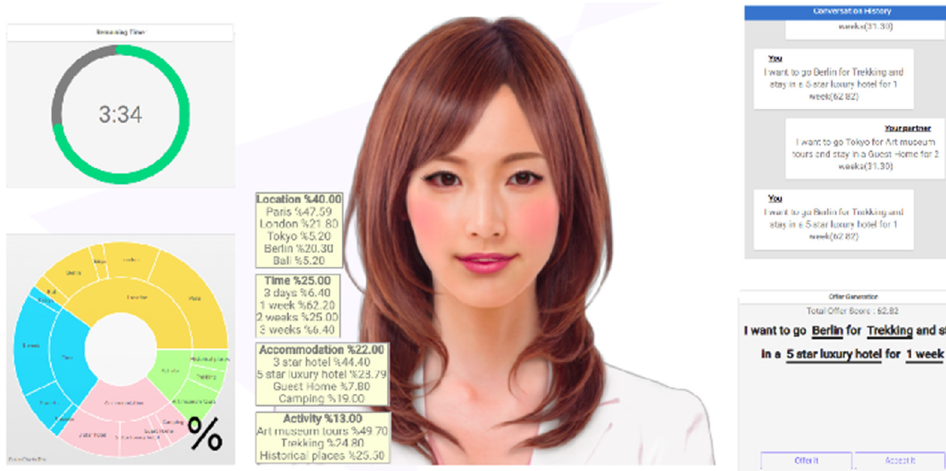
Figure 2. Our Human-Agent Negotiation Interface.